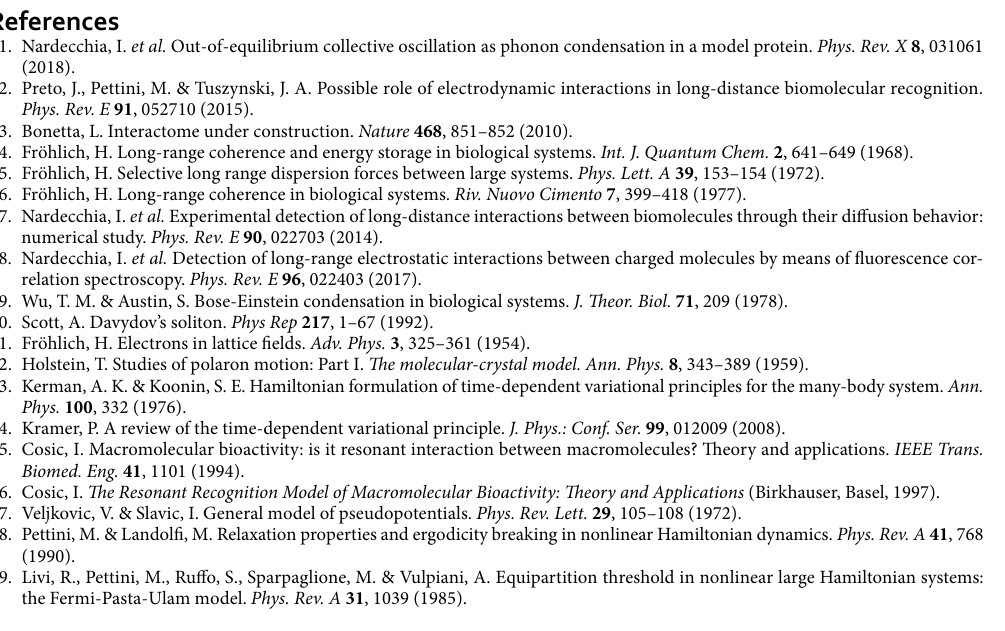
0.3 (red), µ ′ = 0.1 (dark blue), µ ′ = 0. (dark green), ǫ ′ =